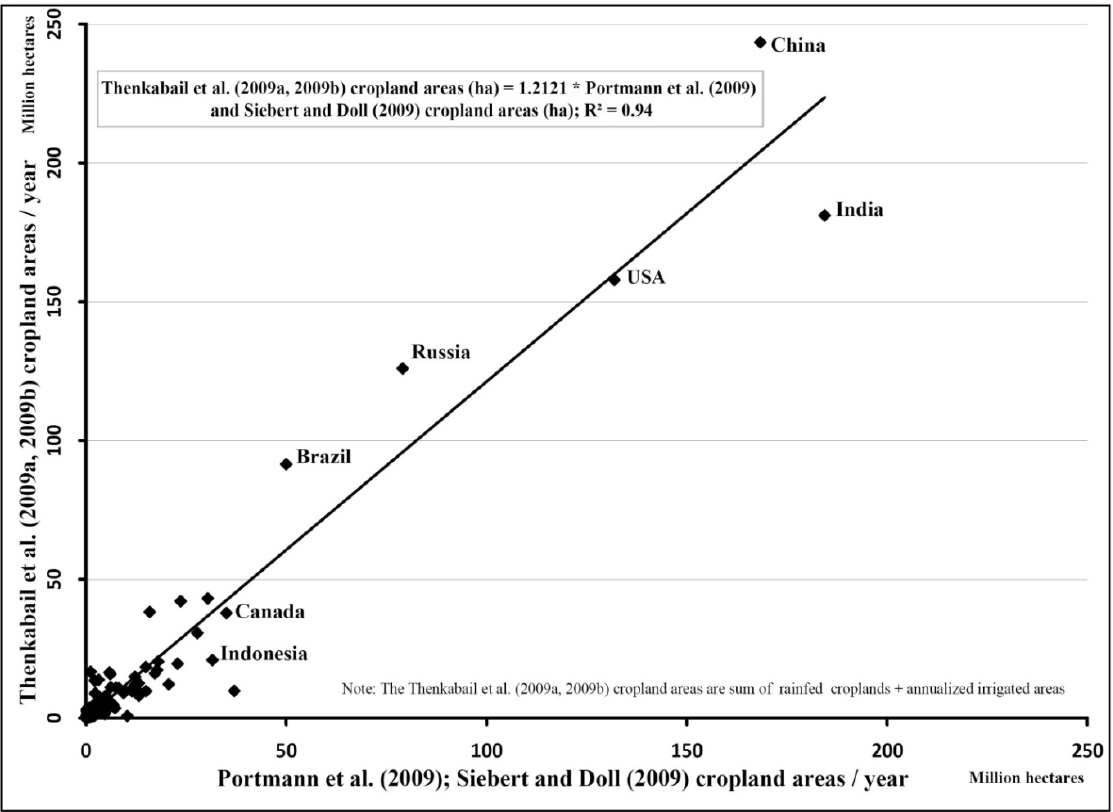
Figure 5b. Cropland areas per year (annualized) for 197 countries [1,2, versus 41,49]. Cropland areas include irrigated plus rainfed crops per year as well as permanent